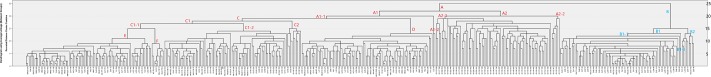
A dendrogram of 473 wild castor materials based on SRAP analysis.